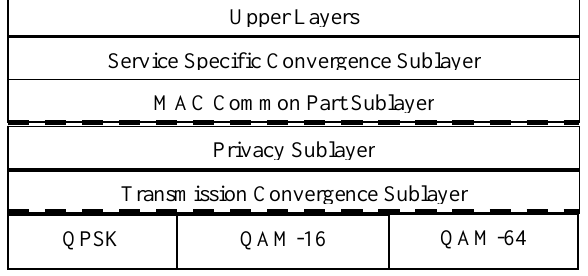
Figure 2. IEEE 802.16 Protocol Layering